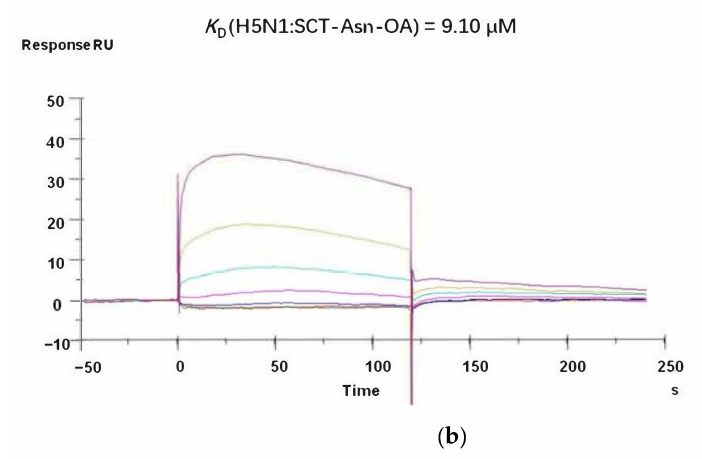
Figure 2. Surface plasmon resonance (SPR) assay characterization between conjugates and hemag- glutinin proteins. ( a ) SCT-Asn-BA with H1N1(A/WSN/1933) protein; ( b ) SCT-Asn-OA with H5N1(A/Hong Kong/483/97) protein. Their K D values are labeled in the corresponding